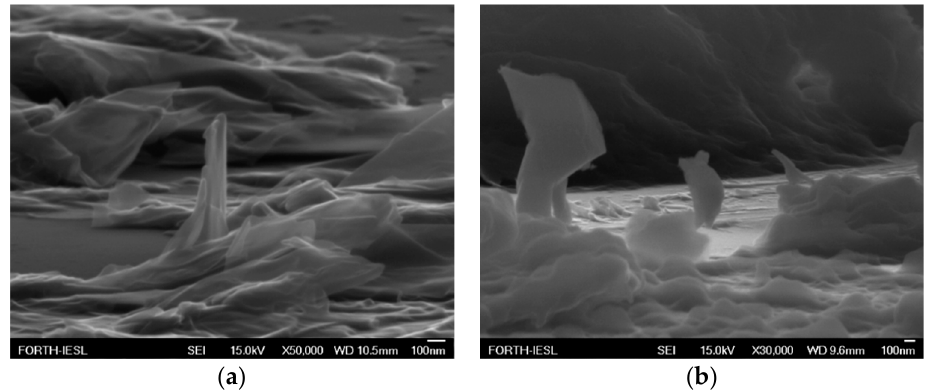
Figure 9. SEM images of a FE cathode edges in the cases of rGO bundles alone ( a ) and P3HT(80% v/v):rGO blend(20% v/v) ( b ). Thickness inhomogeneity due to the applied drop casting method has to be taken into account together with the formation of protruding edges. Impact of rGO sheets is clearly visible especially in ( a ).